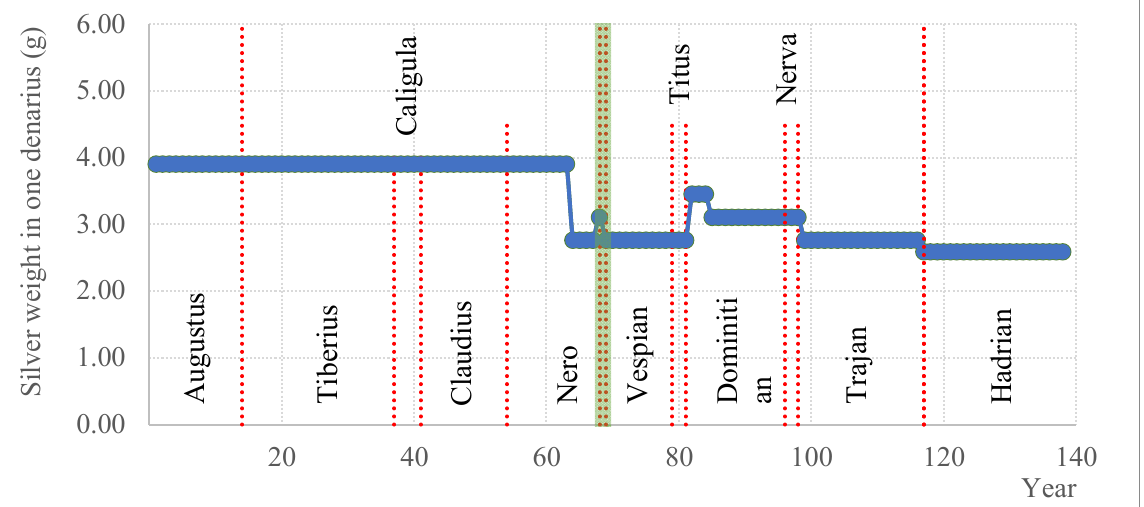
Figure 28. Silver weight in one denarius during the 1st and beginnings of the 2nd century AD. The period of Galba, Otho and Aulus Vitellius is depicted with green.